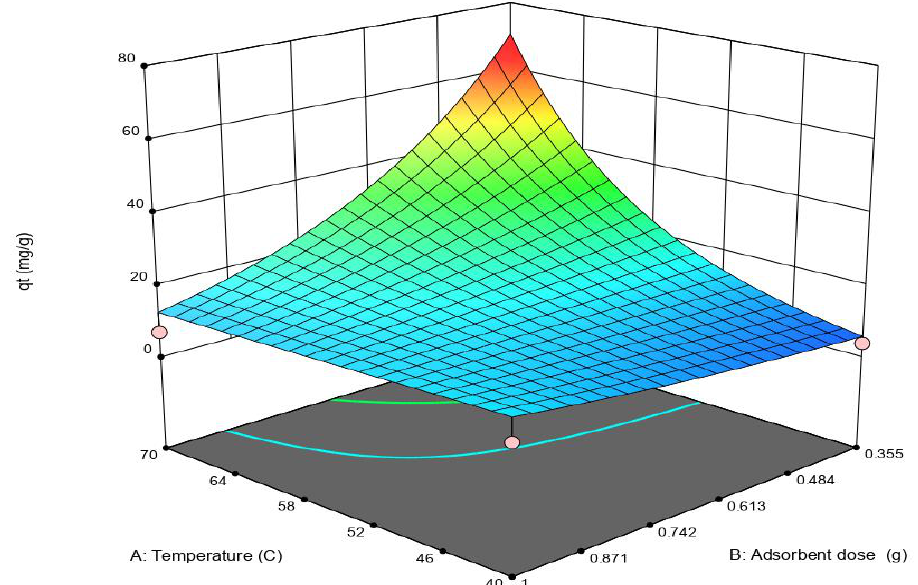
Figure 6. Estimated Response Surface for chromium (VI) adsorption capacity with relevant data points in pink.